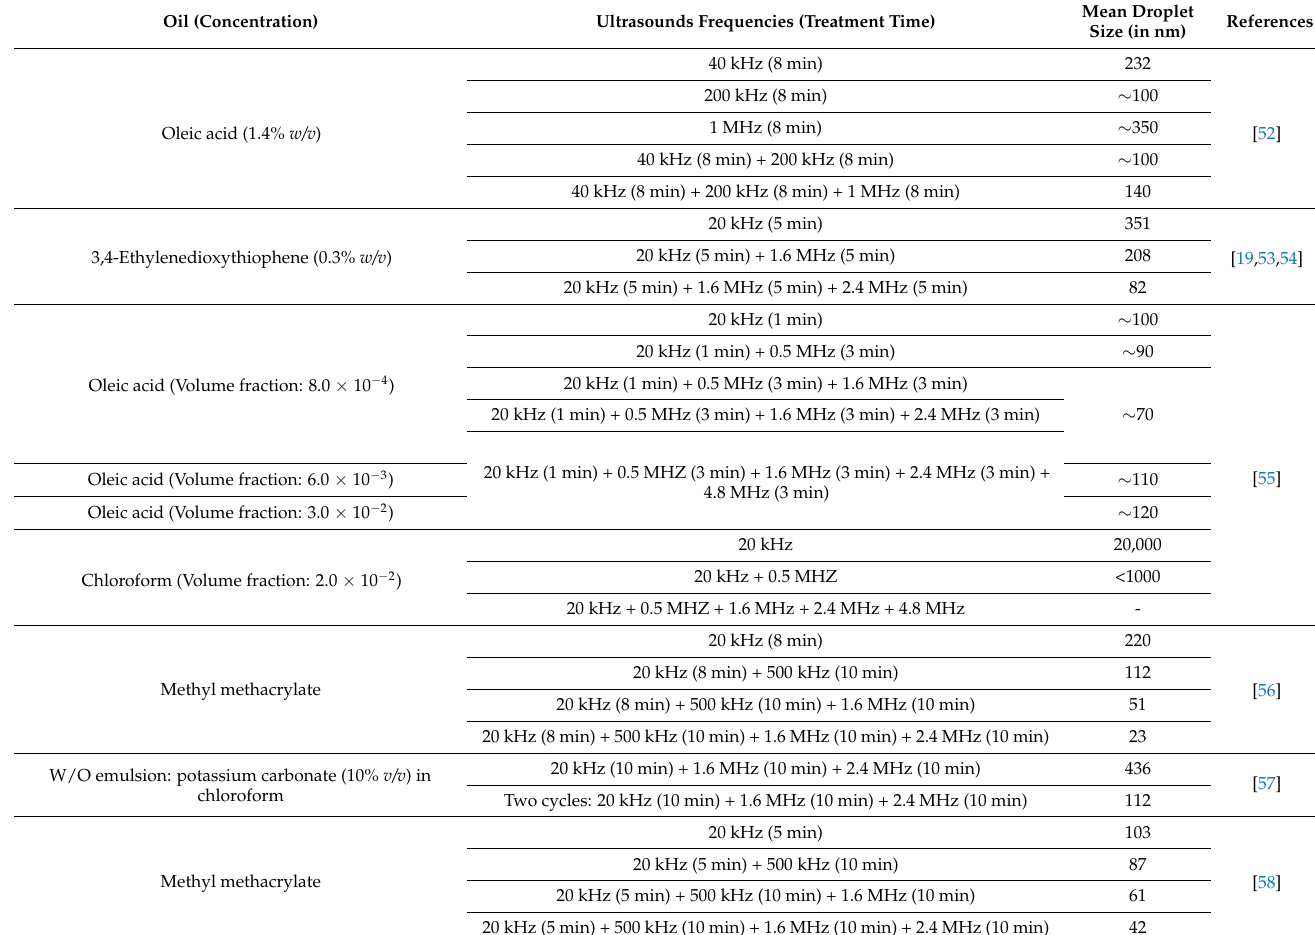
Table 1. Characteristics of emulsions produced by tandem high-frequency ultrasounds